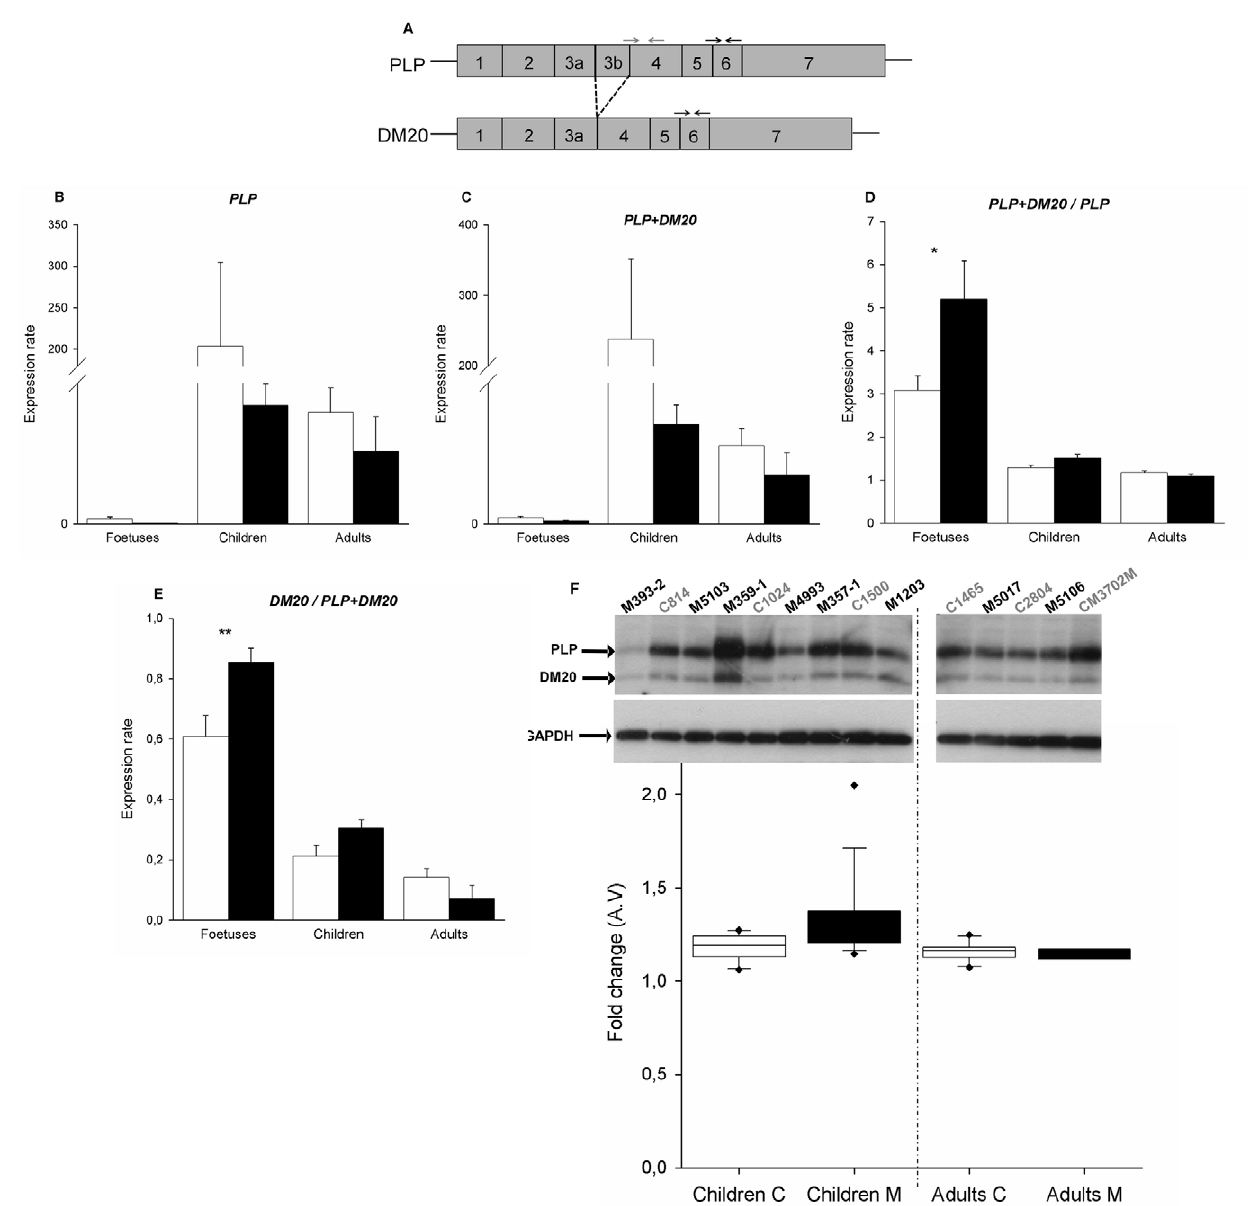
Figure 2. Study of the splice PLP/DM20 in eIF2B-mutated patients brains. A. Transcripts of human PLP1 splice variants. The boxes represent the exons that are transcribed for the different isoforms. The black and grey arrows represent respectively common primers between PLP and DM20 (forward primer between the exons 5 and 6, reverse primer at the end of the exon 6), and specific primers for PLP (forward primer between the exons 3b and 4, reverse primer in the exon 4). B, C. RNA was isolated from control brains (white bars) vs eIF2B-mutated patient brains (black bars) and analyzed by quantitative RT-PCR for expression of PLP and PLP + DM20 . Expression rates were calculated using the formula Mean (2 ‘ -(Ct gene x 2 Ct B2M )) and ratio PLP + DM20/PLP was performed ( D ). E. Extrapolation of the DM20/PLP + DM20 ratio calculating DM20 alone by the formula ( PLP + DM20 )- PLP . Errors bars represent standard error (s.e.m.) (* P , 0.05 ,** P , 0.01, *** P , 0.001). F. Proteins were extracted from controls and eIF2B-mutated patient brains and western blot analysis was performed on the cytoplasmic fractions using antibodies specific for PLP and DM20. GAPDH served as loading control. C: control, M: eIF2B-mutated. The images were quantified using ImageQuant TL software and the box plots below show the relative expression of PLP + DM20/PLP (corrected for GAPDH levels) in control and patients brains. A.V.: arbitrary value. doi:10.1371/journal.pone.0038264.g002 disease status, couple number and ER-stress treatment between the different groups of fibroblasts: eIF2B-mutated, OL and controls. This type of statistical analysis allowed us to maximize the use of available data (relative transcription level of the corresponding gene and systematic bias due to the protocol such as labelling efficacy).